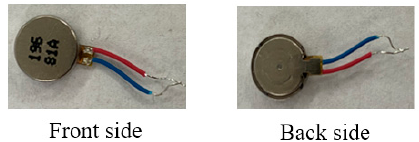
Figure 10. The coin-type vibration motor sample.